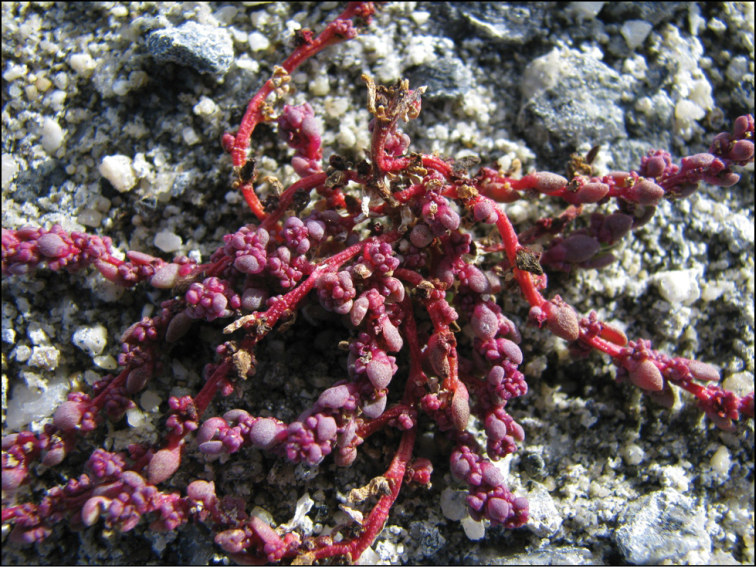
Suaedaolufsenii at fruiting stage. Photograph by Prashant Awale (ca. 4300 m a.s.l., near Pangong Lake, Jammu & Kashmir, India, September 2011).